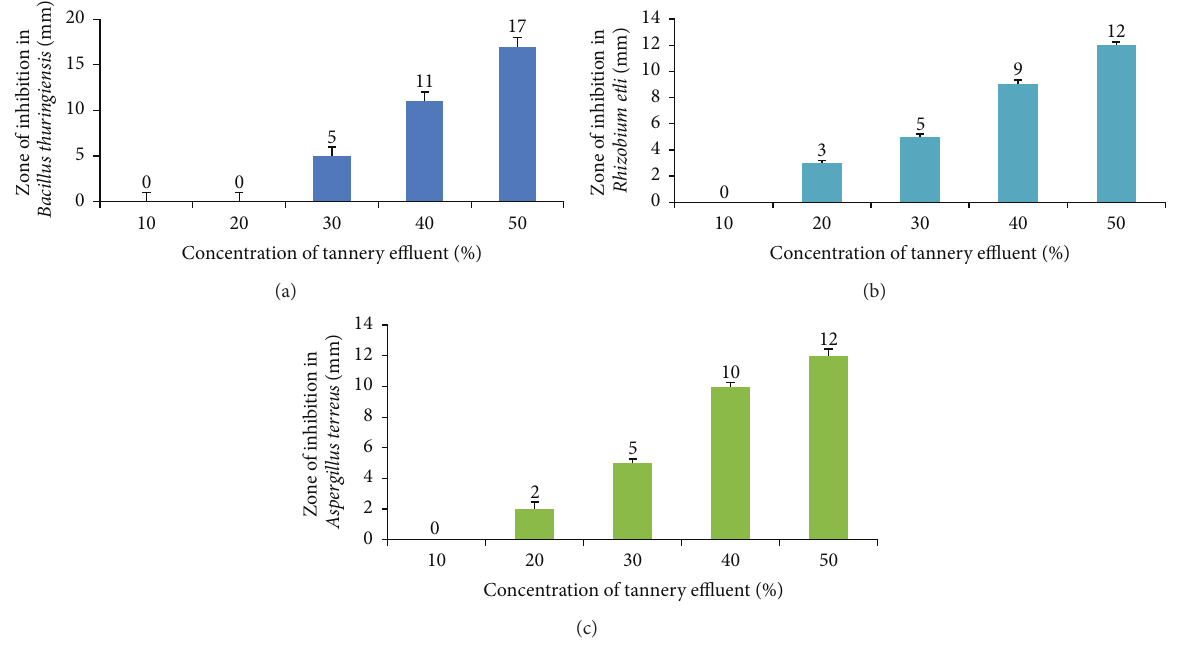
Figure 3: Effect of tannery effluent on ecofriendly microorganisms. (a) Zone of inhibition in Bacillus thuringiensis (mm). (b) Zone of inhibition in Rhizobium etli (mm). (c) Zone of inhibition in Aspergillus terreus (mm).